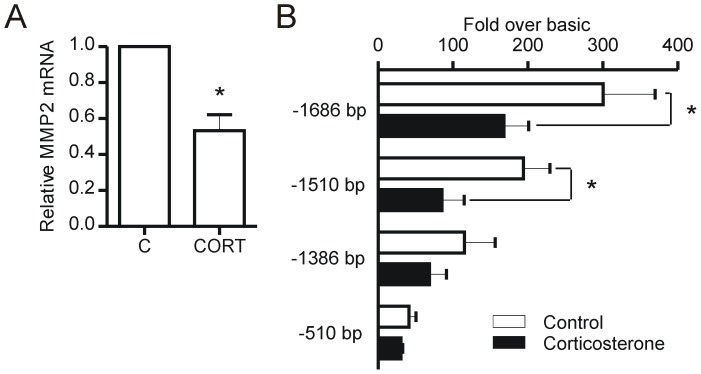
Corticosterone treatment decreases MMP-2 promoter activity.Endothelial cells (1.0×106 cells) were plated in 35 mm2 dishes coated with type I collagen and treated with 600 nM corticosterone for 48 hours. Whole cell lysates were used for qRT-PCR. MMP-2 mRNA levels were decreased with corticosterone treatment (A) (p = 0.006, n = 5). Endothelial cells (7.5×105 cells) were plated in 35 mm2 dishes coated with type I collagen for 24 hours before being transfected with plasmid DNA encoding full length MMP-2 promoter (−1686 bp), or truncated promoter (−1510 bp, −1386 bp, −510 bp) coupled to firefly luciferase (pGL3basic) and then treated with 600 nM corticosterone for 48 hours (B). Renilla luciferase (pRL) was transfected into each well as a control to normalize transfection efficiency. Relative light units were calculated as a ratio to the empty vector condition (pGL3basic) and normalized according to Renilla values to account for well to well variations in transfection efficiency (*p<0.05 vs control, n = 4 independent experiments).